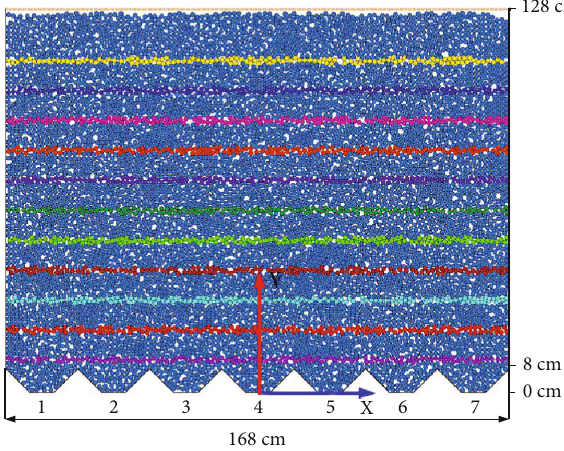
Figure 1: Schematic diagram of the mass draw and synchronous fi lling no-top-pillar shrinkage stoping method: (1) return airway, (2) top-pillar, (3) raise, (4) cross heading, (5) barrier pillar, (6) remaining ore, (7) drift pillar, (8) drawpoint, (9) haulage drive, (10) unmined ore, (11) fi lling material, and (12) barrier.